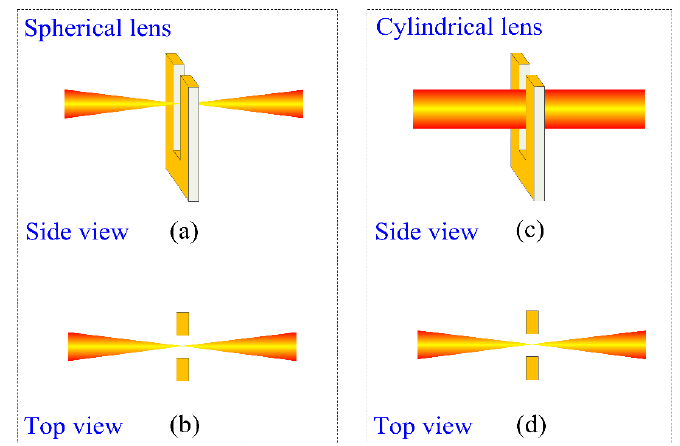
Figure 2. Schematic plot of a QTF and laser beam using different focusing lenses: ( a ) side view for a spherical lens; ( b ) top view for a spherical lens; ( c ) side view for a cylindrical lens; ( d ) top view for a cylindrical lens.